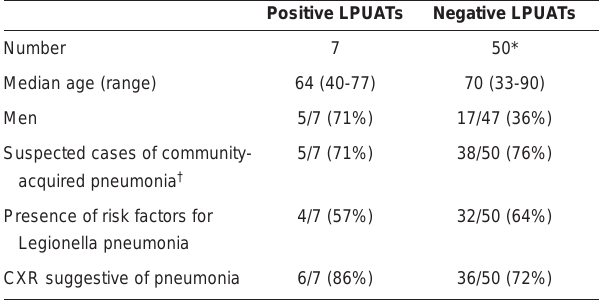
TABLE 1 Patient demographics, presence or absence of recognized risk factors and final chest radiographic